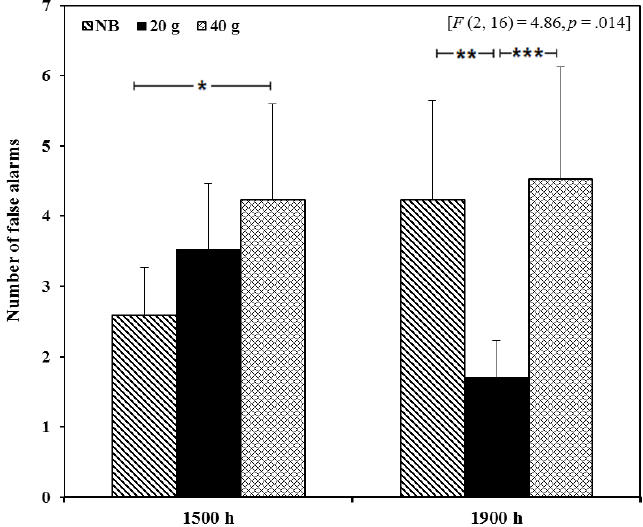
Figure 2. The effects of consuming breakfast cereal (20 g or 40 g) or no breakfast (NB) prior to exercise on RVIP false alarms 5 h (1500 h) and 9 h (1900 h) post-exercise, in habitually active females ( n = 17). (* p < 0.05, ** p < 0.01, *** p < 0.001).